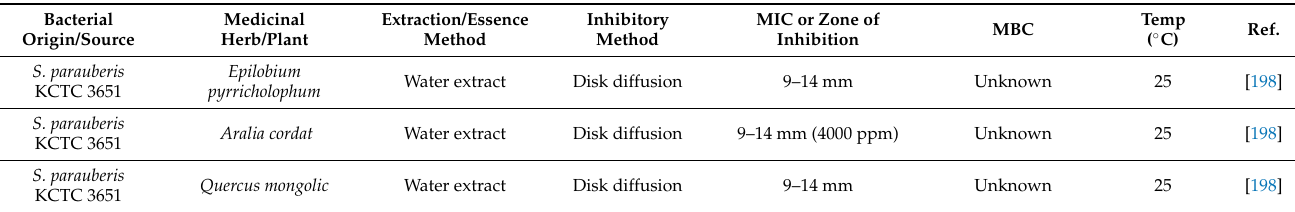
Table 6. In vitro inhibitory of medicinal /plants to S.